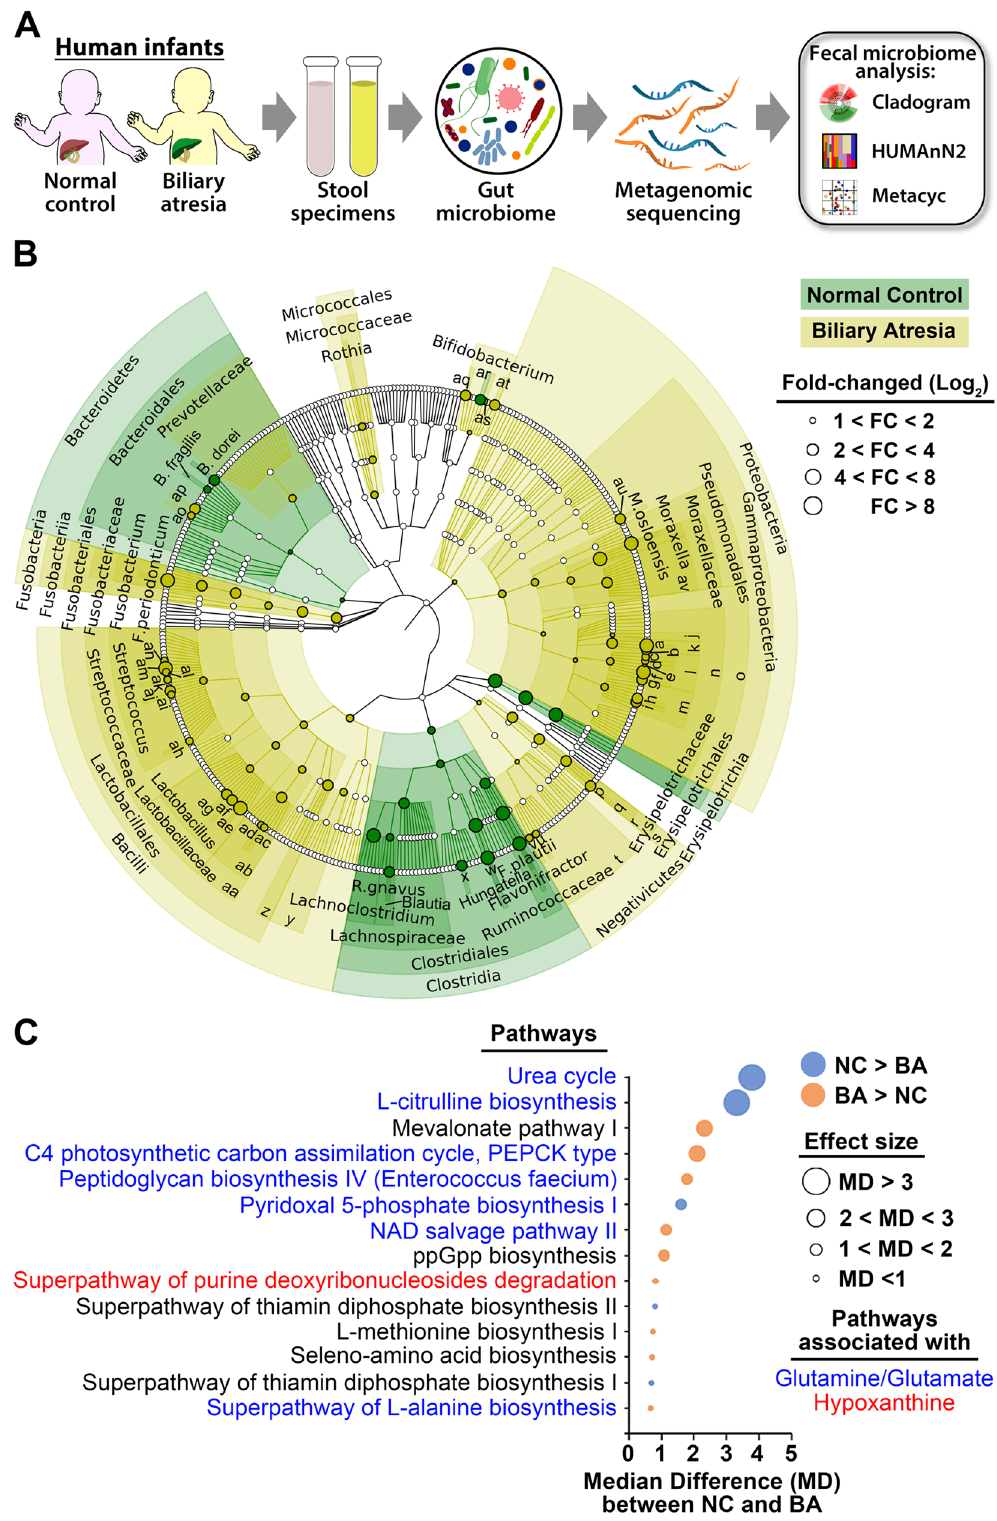
Fig. 5 Microbiome analysis and functional pathways in human fecal specimens. A Schematic overview of fecal microbiome analysis from infants with biliary atresia and healthy controls. B Cladogram showing a signi fi cantly different abundance of bacterial taxa with Log 2 scaled fold changes between infants with biliary atresia ( n = 102) and age-matched controls ( n = 28) (adjusted p value <0.05). C Functional pathways signi fi cantly regulated by microbial community of biliary atresia and controls, calculated by HUMAnN2 on the basis of MetaCyC pathways (adjusted p value <0.05). Source data for this fi gure are provided as a Source data fi